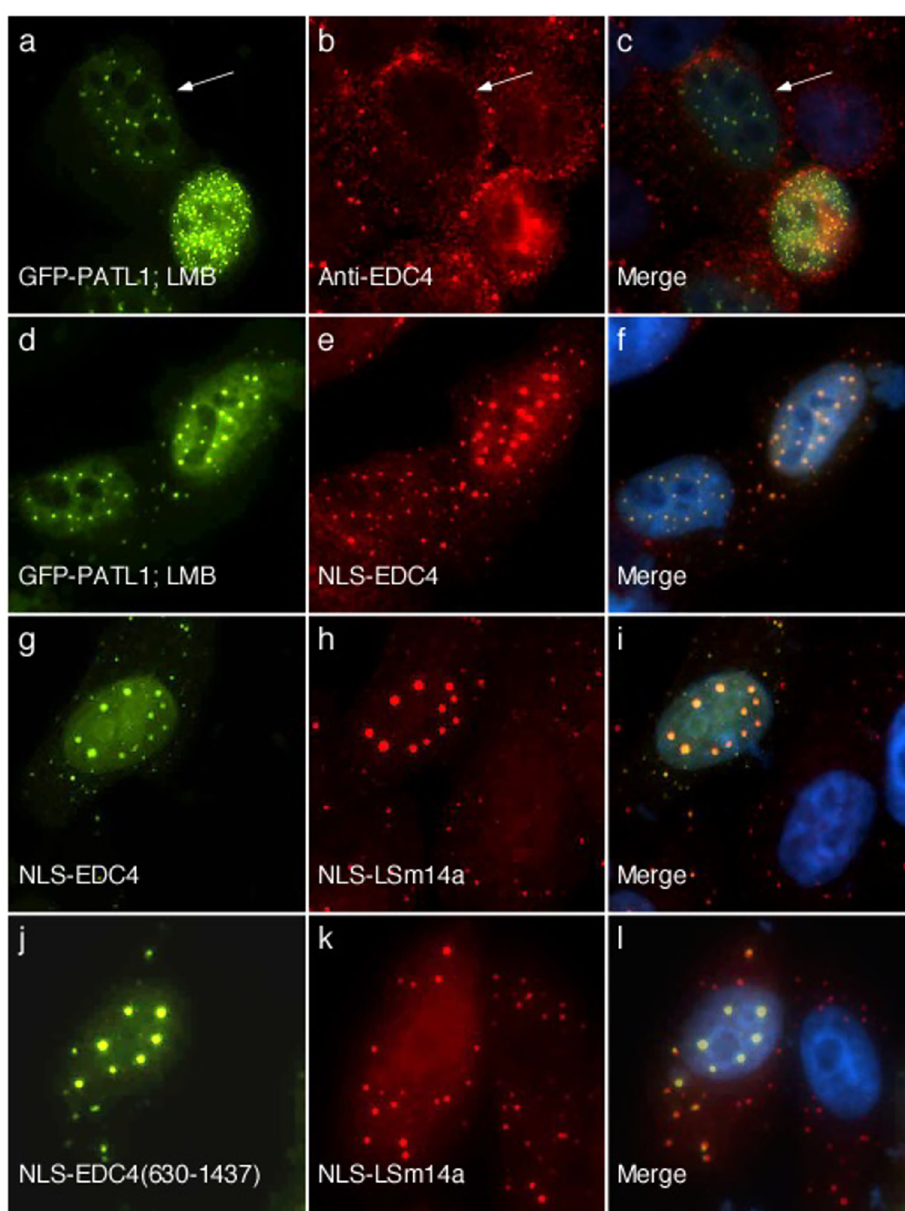
Fig 3. Full-length PATL1 interacts with EDC4. Transfection of HEp-2 cells with GFP-PATL1 followed by treatment with leptomycin B (LMB) resulted in localization of PATL1 in one of three nuclear patterns: homogeneous (not shown), finely speckled and nuclear dot (panel a). Endogenous EDC4 remained in cytoplasmic dots, despite treatment with LMB (panels b, c). White arrows in a-c indicate a representative cell with GFP-PATL1 in nuclear dots, while endogenous EDC4 remained in P-bodies. Co-expression of GFP-PATL1 (panel d) and NLS-EDC4 (panels e, f) and subsequent treatment with LMB resulted in the two proteins localizing to nuclear dots in all cells that expressed both proteins. NLS-EDC4 recruits NLS-LSm14a to nuclear dots and the N-terminus of EDC4 is required for the observed interaction. Co-expression of NLS-EDC4 (panel g) and NLS-LSm14a (panel h) resulted in localization of the two proteins to nuclear dots (panel i) in 86 +/-4% of cells with both proteins in the nucleus. In cells transfected with GFP-NLS-EDC4(630–1437) and NLS-LSm14a, GFP-NLS-EDC4(630–1437) was detected in nuclear dots (panel j), while NLS-LSm14a (panel k, l) was distributed diffusely throughout the nucleus. NLS-LSm14a did not co-localize with GFP-NLS-EDC4(630–1437) in nuclear dots in any of the cells that contained both proteins in the nucleus. Mouse monoclonal anti-GFP antibody was used to detect GFP-PATL1 in a and d, and GFP-EDC4(630–1437) in panel j. Human serum was used to detect EDC4 in b, e, and g. Rabbit anti-LSm14a antiserum was used to detect NLS-LSm14a in h and k. Note that the rabbit antiserum detected endogenous LSm14a in cytoplasmic dots (panels h, k). Merge